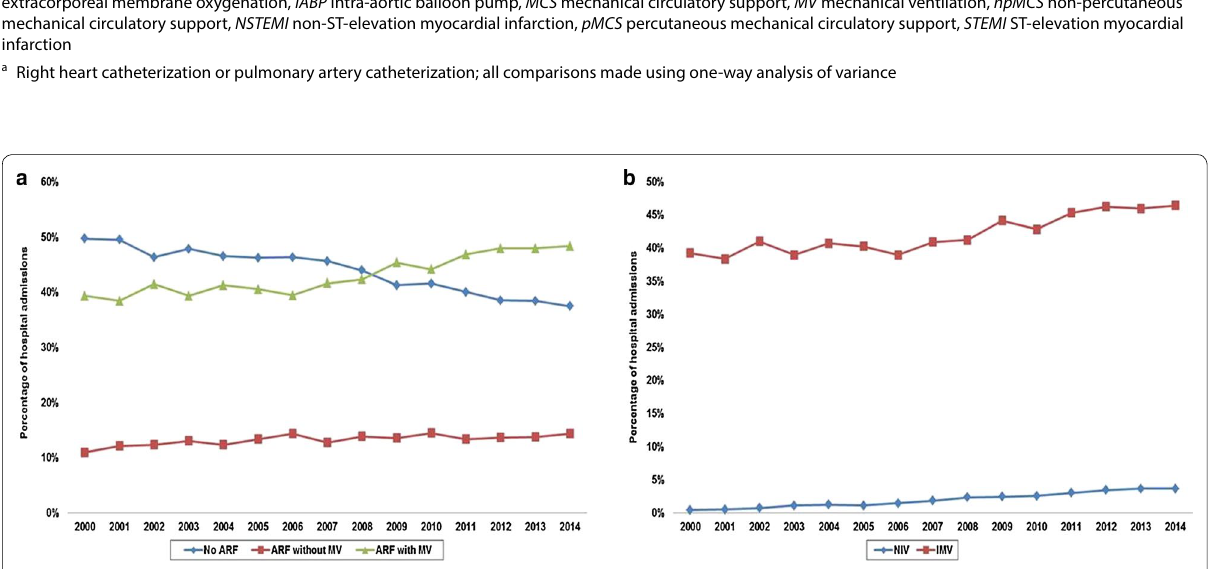
Fig. 1 Prevalence of ARF and MV in AMI-CS. a 15-year trends in the incidence of no ARF, ARF without MV and ARF with MV in AMI-CS; b 15-year trends in NIV and IMV use in AMI-CS with ARF; all p < 0.001 for trend. AMI acute myocardial infarction, ARF acute respiratory failure, CS cardiogenic shock, IMV invasive mechanical ventilation, MV mechanical ventilation, NIV noninvasive